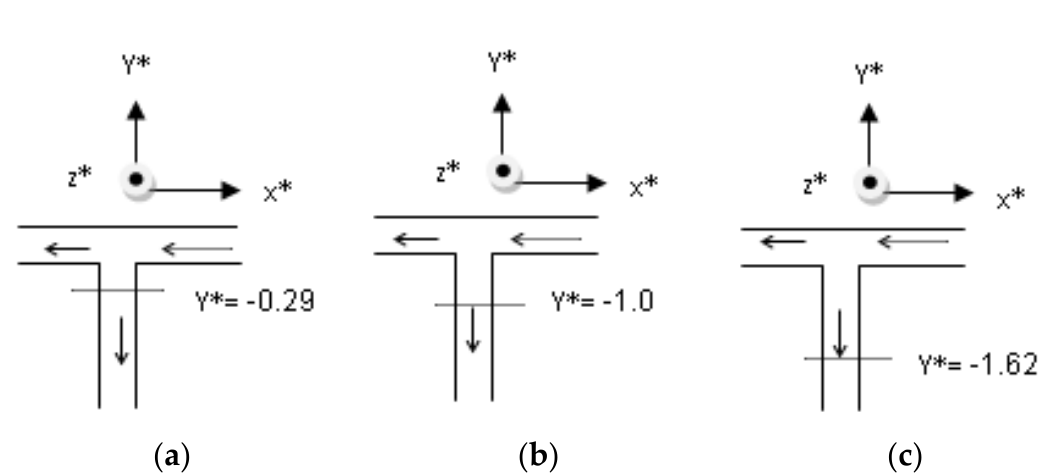
Figure 2. The measurement locations (a): Y*=-0.29, (b): Y*=-1.00 and (c): Y*=-1.62 in the channels